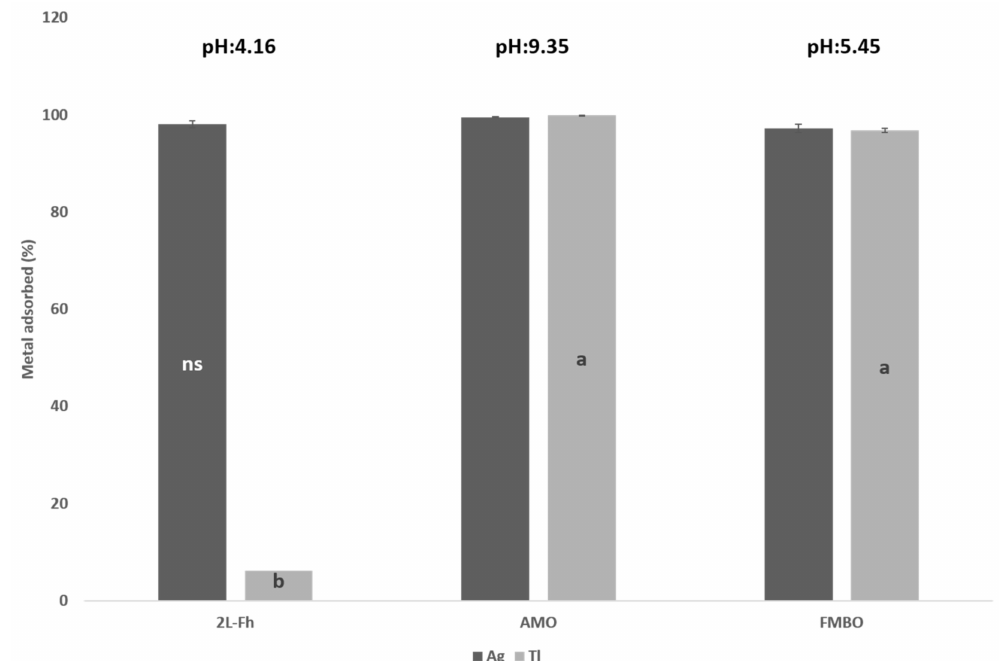
Figure 5. Content of Ag + and Tl + adsorbed (%) onto 2L-Fh, AMO and FMBO, and the final pH (upper part) after three days of interaction of NO 3 Ag (20.0 µ M) and NO 3 Tl (100.0 µ M) solutions with nano-amorphous metal oxides. For each series different letters denote significant differences among nanomaterials according to Tukey HSD Test ( p < 0.05). ns: no significant